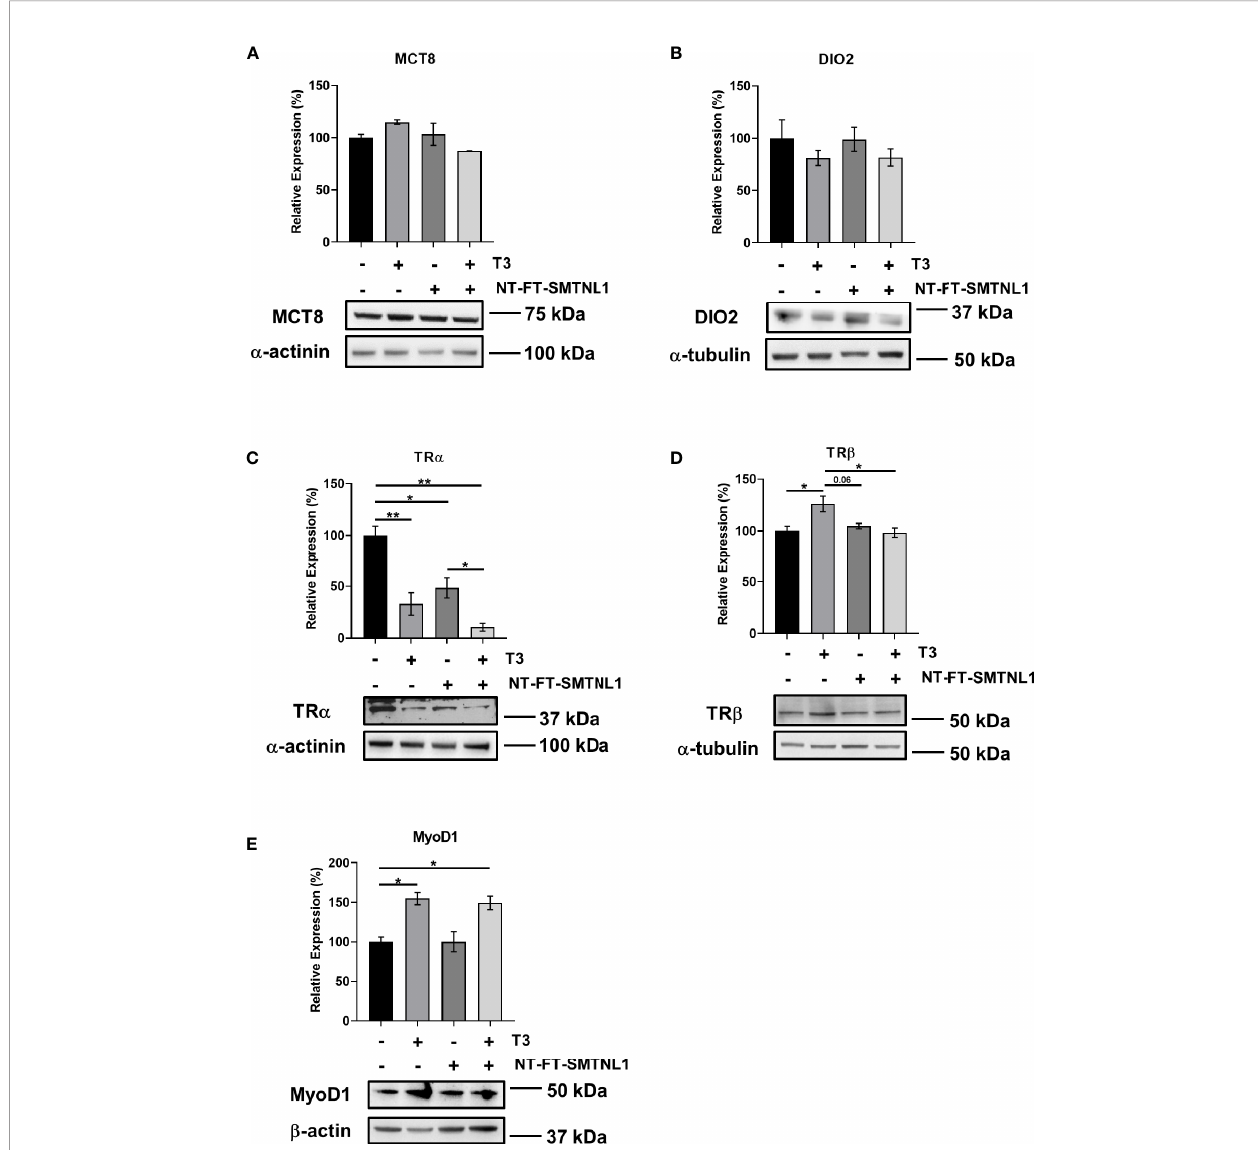
FIGURE 5 | T3 treatment and SMTNL1 overexpression in fl uence the expression of regulatory proteins involved in T3 signaling/action. (A – C) Myoblasts were transfected with either empty vector or NT-FT-SMTNL1 and were differentiated with a simultaneous 72-hour T3 treatment starting from Day 4. Proteins from whole-cell lysates were analyzed by Western blot using anti-MCT8 (A) , anti-DIO2 (B) , anti-TR a (C), anti-TR b (D), and anti-MyoD1 (E) . Values represent n=3-5, mean +/- SEM. Data were normalized to the empty vector-transfected control. Groups were compared using One-way ANOVA and Tukey ’ s post hoc test, p < 0.05 (*), p < 0.01